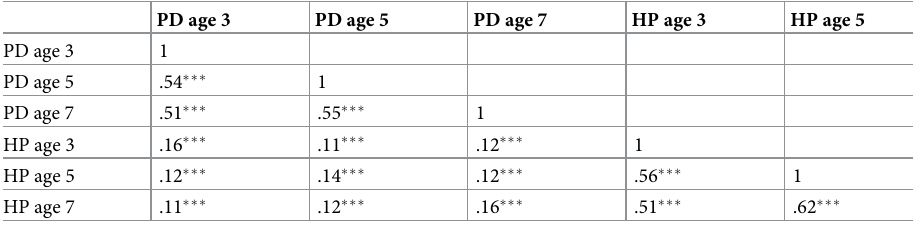
Table 3. Correlations among the main variables in the analytic sample (n =